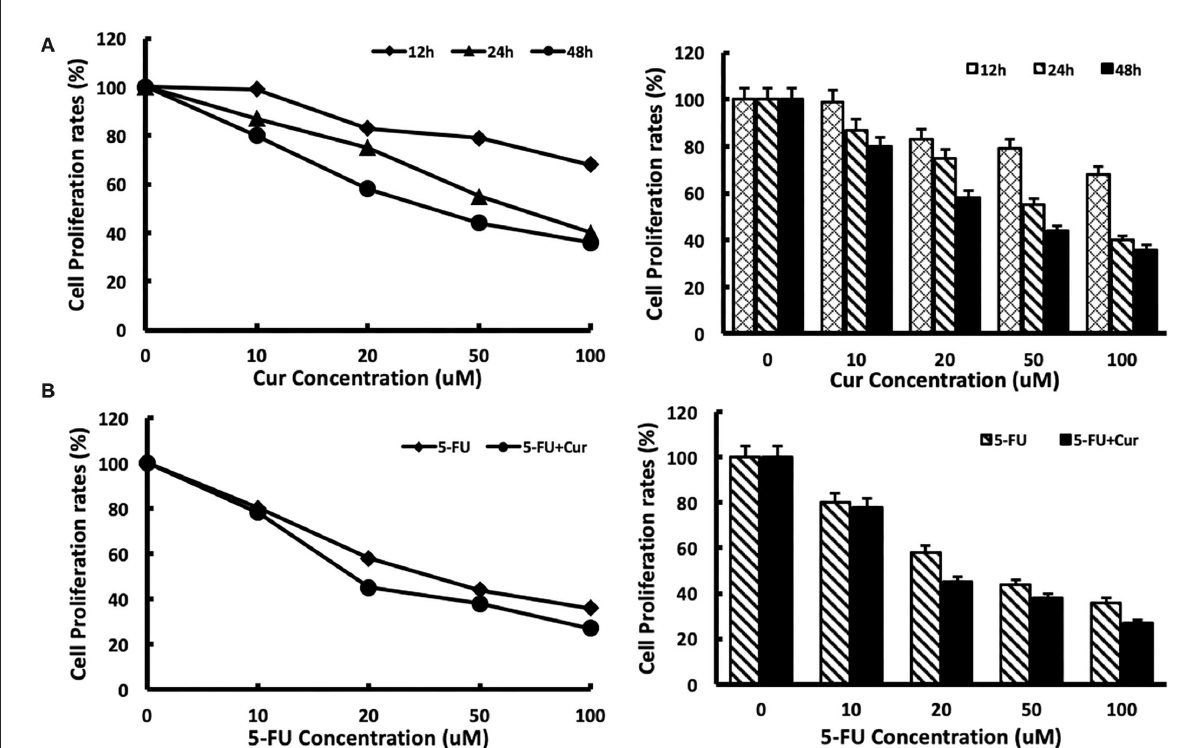
FIGURE1 Cytotoxicity of 5-FU in SW480 cells is enhanced by curcumin. (A) Cytotoxicity of curcumin was determined after exposure of SW480 cells to curcumin with different concentrations (0, 10, 20, 50, and 100 µ M) and different times (12h, 24h, and 48h). Cell viability was measured with the MTT analysis. (B) Cytotoxicity of 5-FU was determined after exposure of SW480 cells to 5-FU alone and 5-FU in combination with 5 µ M curcumin for 48h. Cell viability was measured with the MTT analysis. The results are provided as mean values with standard deviations from at least three independent